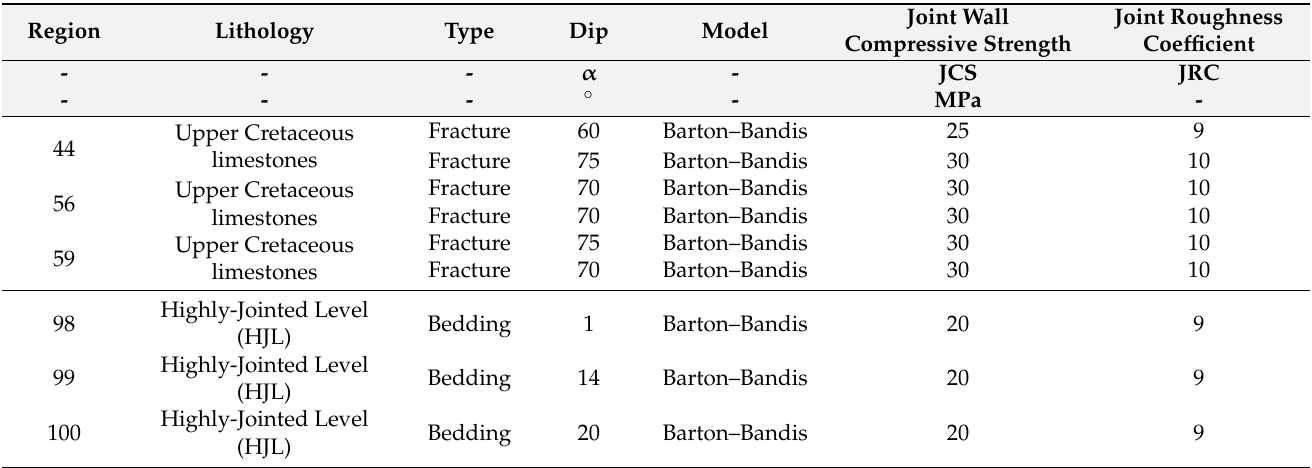
Table 5. Synthesis of physical and mechanical parameters used for the joint sets. In this table, only the characteristics of the regions directly involved in DSGSD are reported. For location of different regions, please refer to Figure